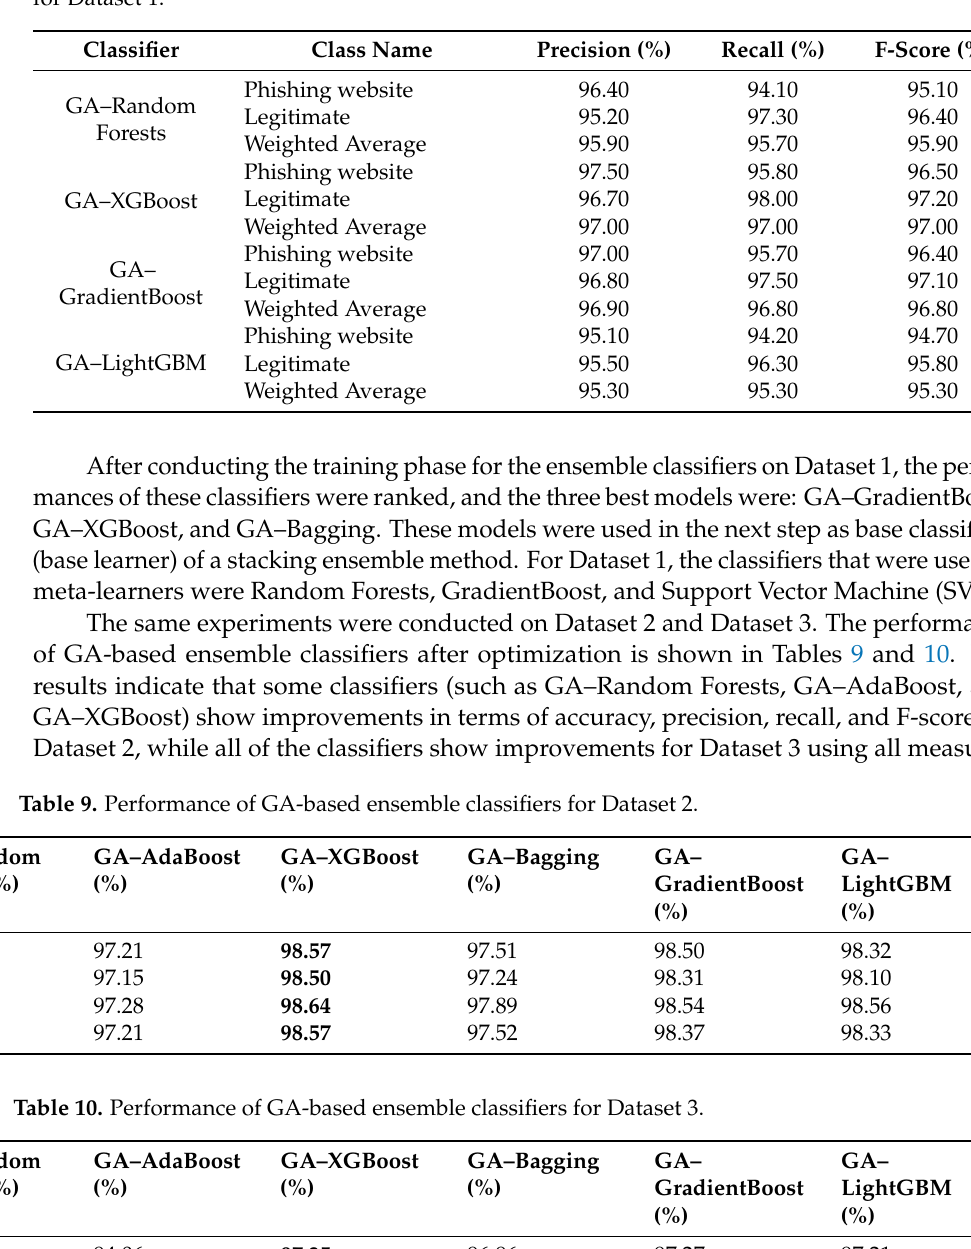
Table 8. Results of performance evaluation measures when detecting phishing and legitimate classes for Dataset 1.